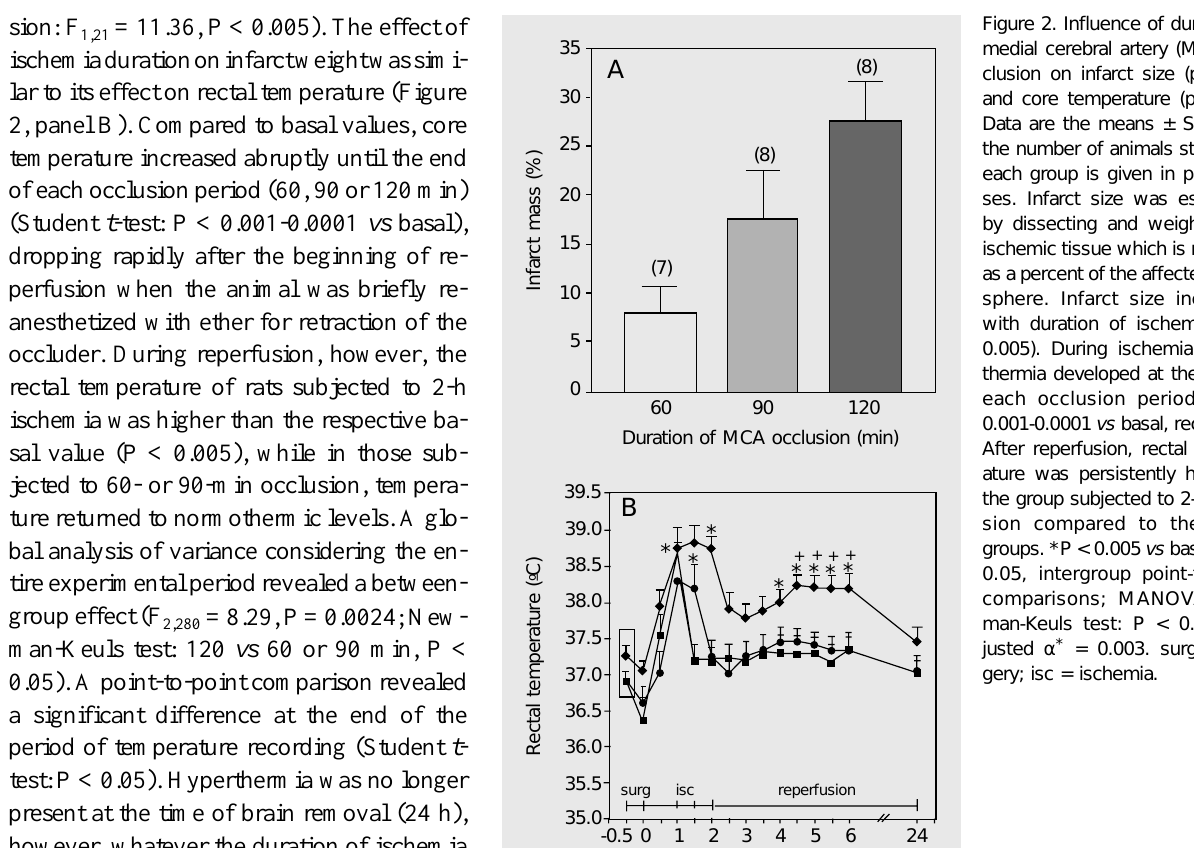
Figure 1. Relationship between infarct size estimated by mass and volume of ischemic brain tissue. Data are reported as percent infarct in relation to the affected hemisphere. Volume was estimated by plethysmography by two pairs of observers (panels A and B) and by using an image analysis system (panel C). The data in panel A were obtained by S.J.Y. and L.K.C.M., the data in panel B by S.C.L.R. and C.J.L., and the data in panel C by